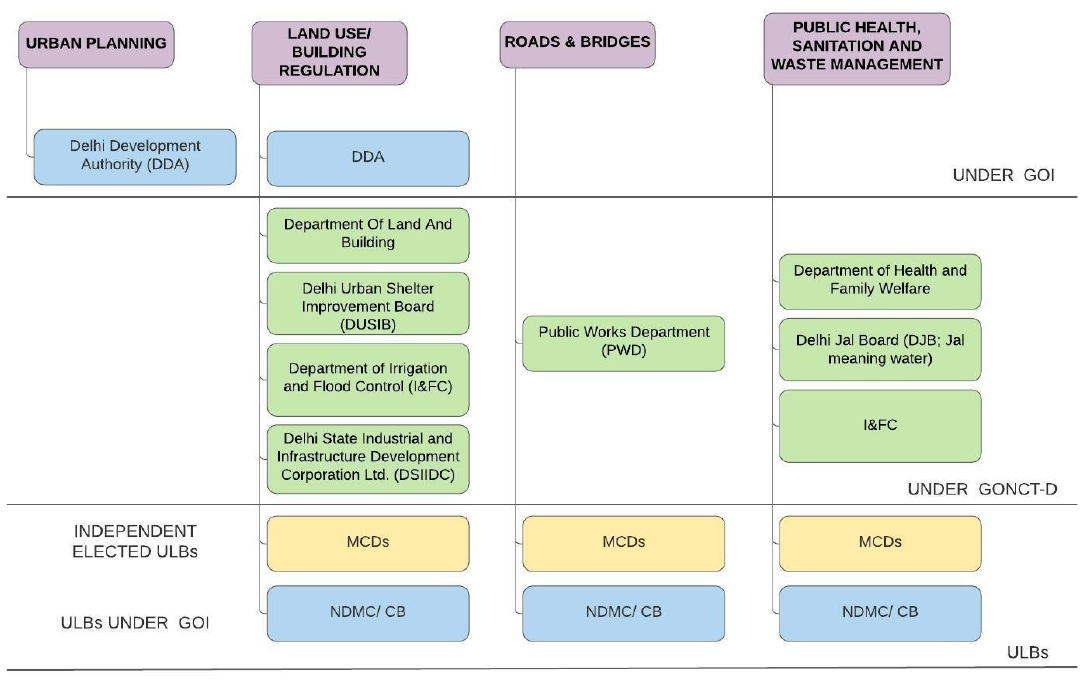
Figure 6: Broad mapping of functional areas across Delhi's agencies and departments